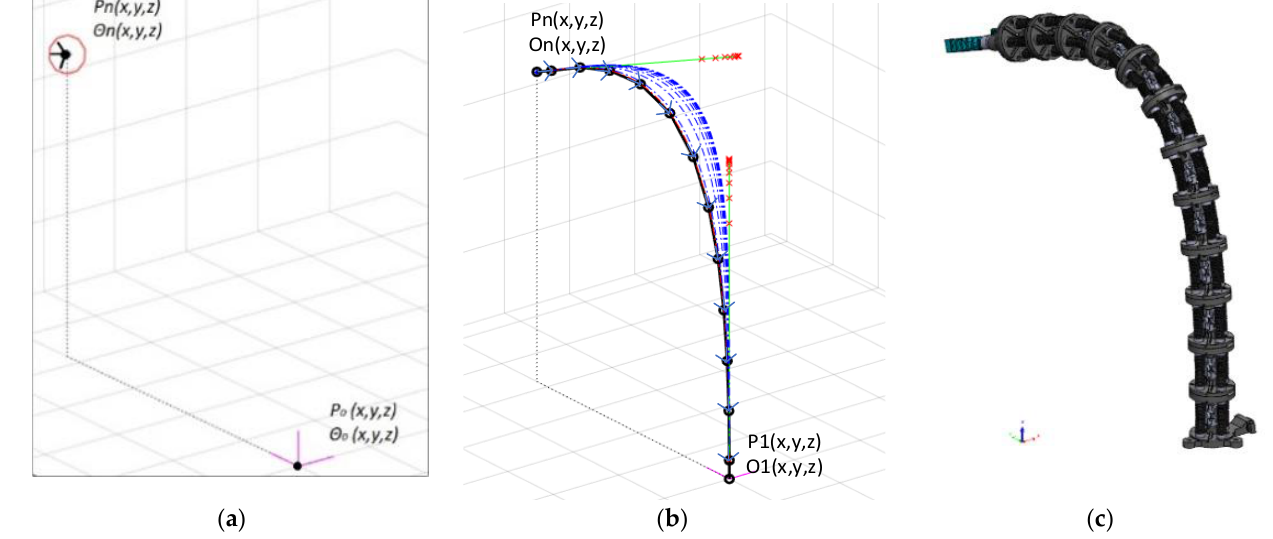
Figure 2. S-GUIDE method steps (a) Task specification initial points (b) Attached robot shape on the Bézier curve (c) Robot shape based on the algorithm results. B é zier curve ( c ) Robot shape based on the algorithm